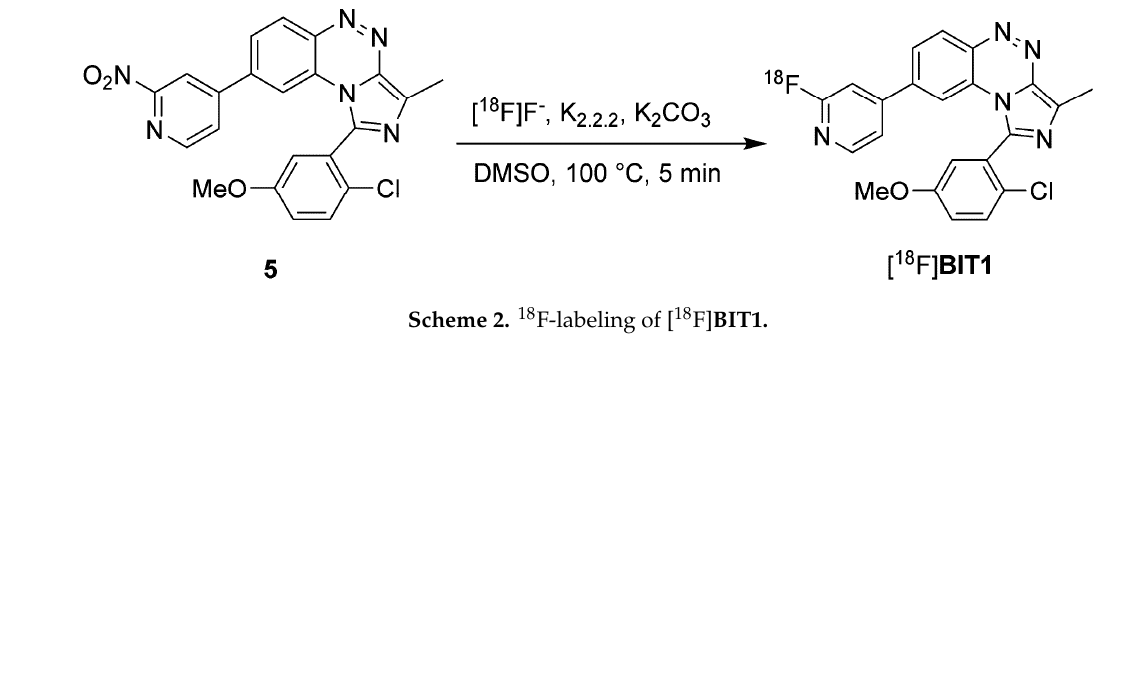
Figure 3. ( A ) Semi-preparative radio- and UV-HPLC chromatograms of [ 18 F] BIT1 (conditions: Reprosil-Pur C18-AQ, 250 x 10 mm, 46% MeCN/20 mM NH 4 OAc aq ., 5.5 mL/min); ( B ) Analytical radio- and UV-HPLC chromatograms of the final product of [ 18 F] BIT1 spiked with the non-radioactive reference BIT1 (conditions: Reprosil-Pur C18-AQ, 250 x 4.6 mm, gradient system with eluent mixture of MeCN/20 mM NH 4 OAc aq ., 1.0 mL/min). In vitro Stability and Lipophilicity of [ 18 F] BIT1 The radioligand [ 18 F] BIT1 was stable (radiochemical purity ≥ 99%) in phosphate-buffered saline (PBS), pig plasma, n -octanol, as well as in the saline formulation containing 10% ethanol at 40 °C for up to 1 h. The lipophilicity was determined by the shake-flask method in the n -octanol/PBS system. With a logD 7.4 value of 1.81 ± 0.05, [ 18 F] BIT1 falls within the range of radiotracers with optimal brain passive diffusion [35–37]. However, the calculated coefficient distribution value (ACD/Labs, Version 12.0, Advanced Chemistry Development, Inc.) displayed value of 4.03. The significant deviations between the calculation and experimental methods were observed in particular when the pattern of connectivity and non-bonded intramolecular interactions are not included in the applied database [38–41]. Moreover, the big discrepancy between the experimental and the calculated logD 7.4 value was already observed for our PDE2 tracer [ 18 F] TA5 and has been previously discussed [25]. It is assumed that the experimentally determined higher hydrophilicity of [ 18 F] TA5 might be due to the solvation effect related to hydrogen bonding and ionization of the radioligand in the aqueous buffered system [25,35]. Whereas with the software-based determination, this effect may be